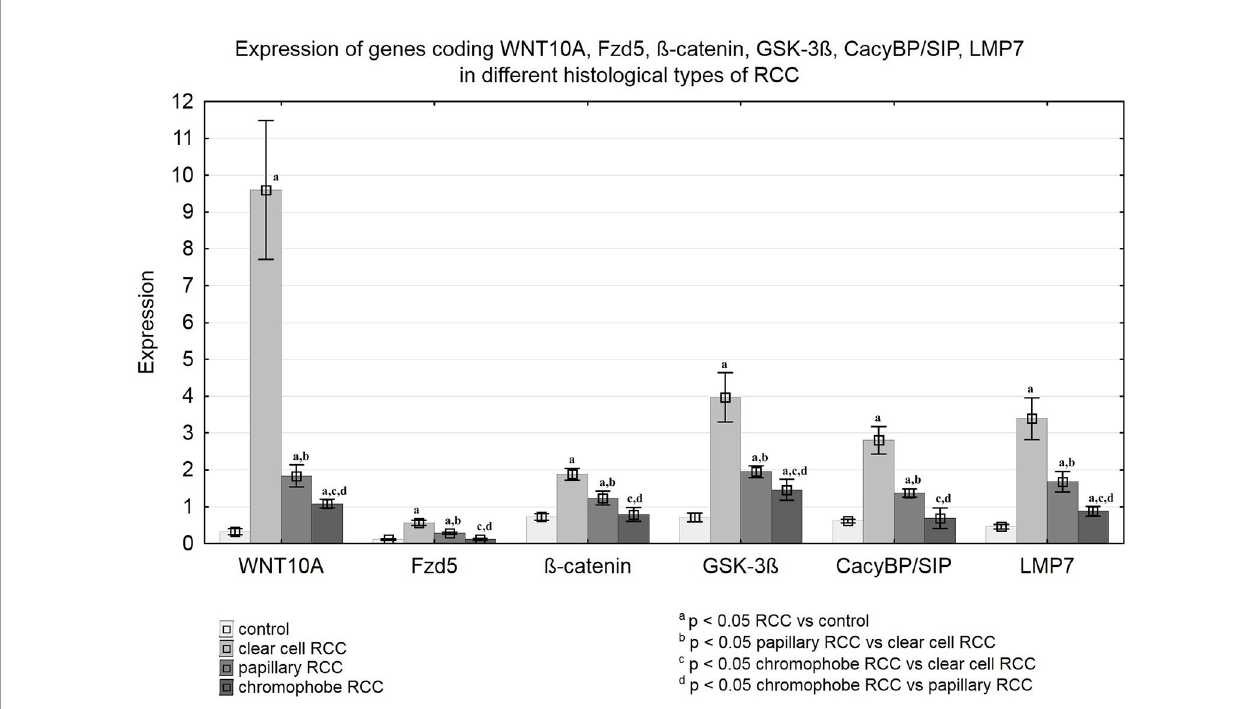
FIGURE 7 | Expression of genes coding WNT10A, Fzd5, b -catenin, GSK-3ß, CacyBP/SIP, LMP7 in clear cell RCC, papillary RCC, chromophobe RCC and non- malignant renal